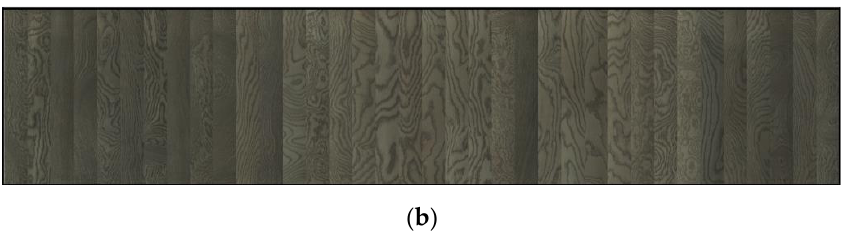
Figure 2. Pretreatment results. ( a ) Unprocessed single image. ( b ) 36 images after pretreatment.